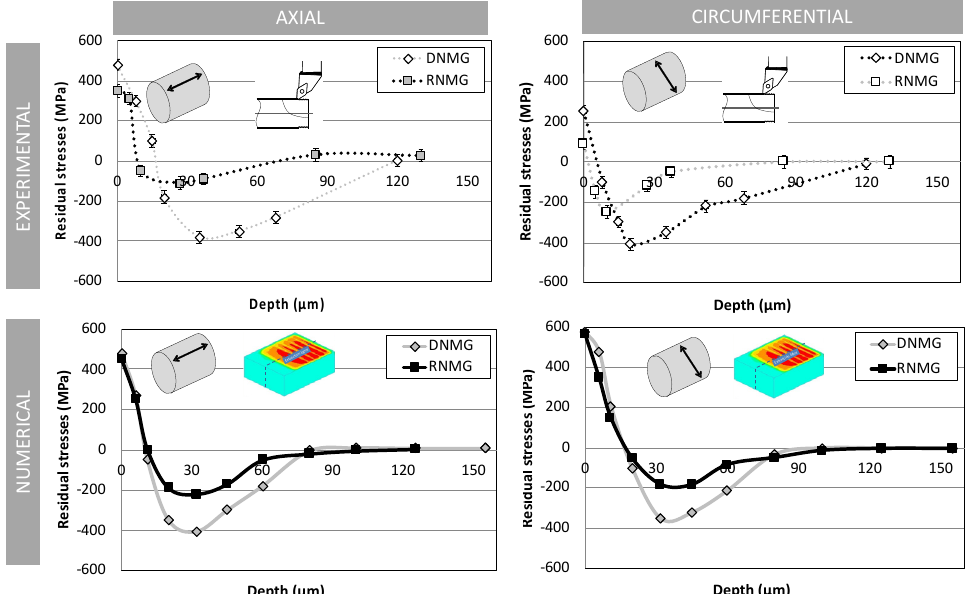
Figure 11. Effect of insert geometry on residual stresses.